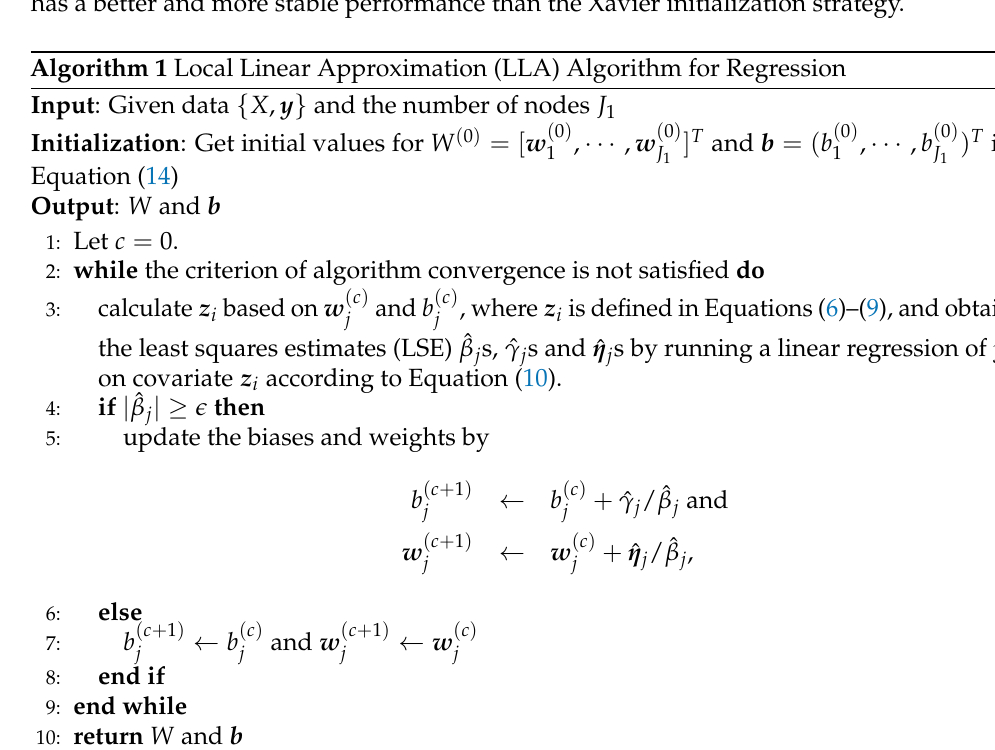
Algorithm 1 Local Linear Approximation (LLA) Algorithm for